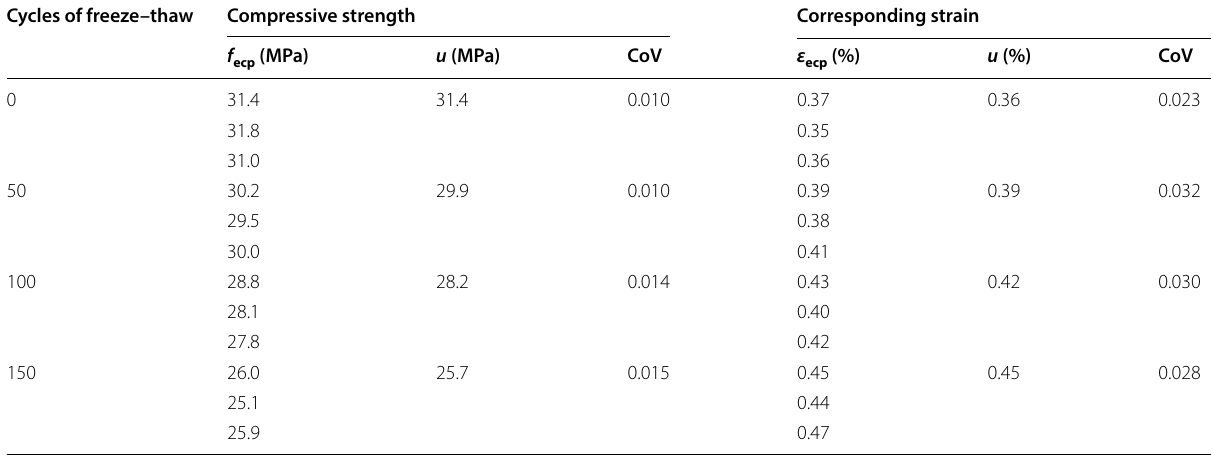
Table 4 Compressive properties of ECC prismatic specimens.